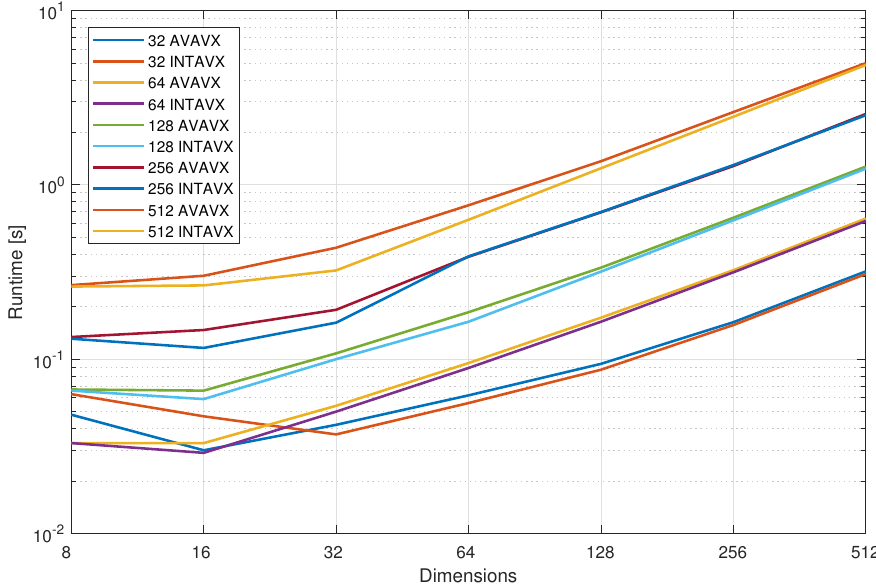
Figure 2. Runtime performance of PSO (Vincent function)—various